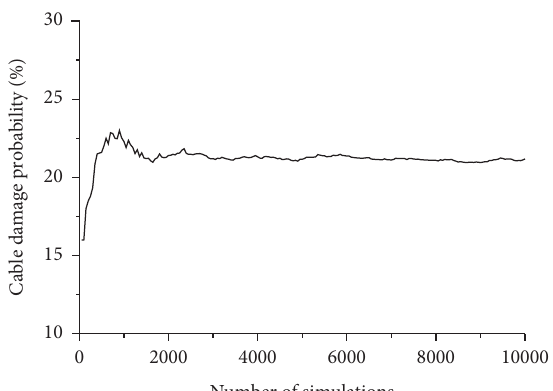
Figure 8: Histogram of the maximum cable strain ε